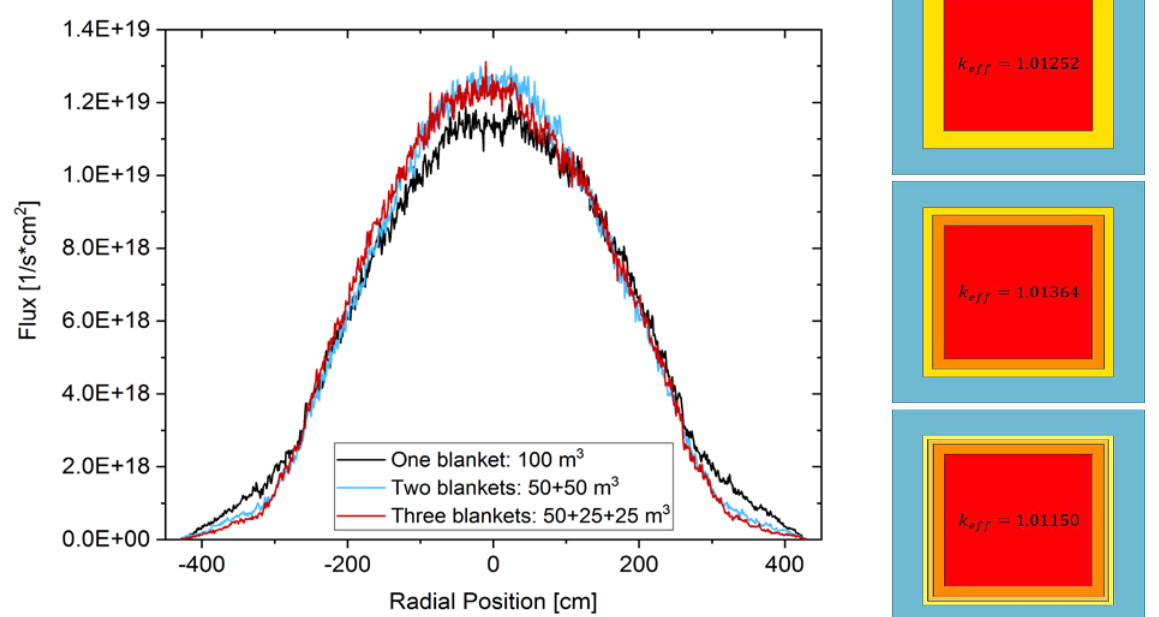
Figure 6. Multi-fluid layouts. Flux distribution and k effective in the cases with one, two and three blankets. In the representation on the right, the active core is in red while the lead reflector is in